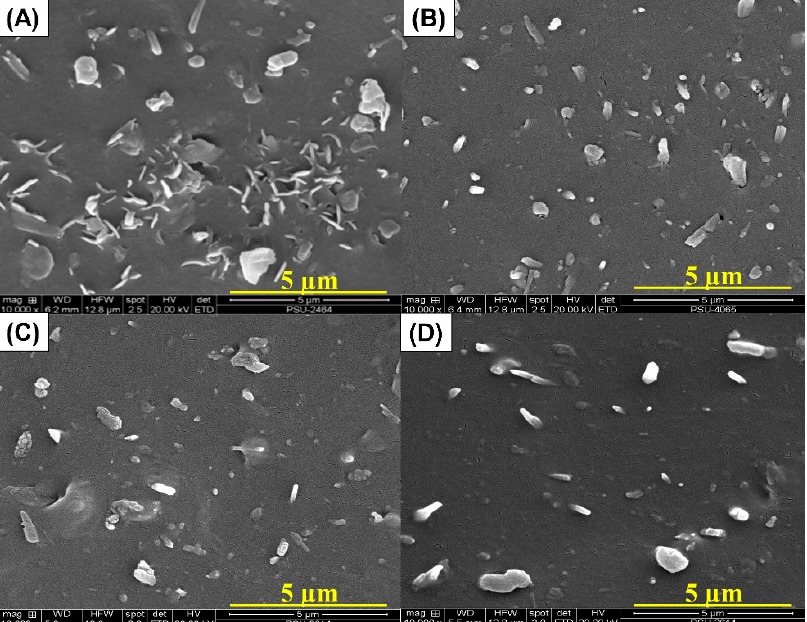
Figure 13. SEM images of the tensile fracture surfaces of NR/HNT composites in the presence of MNR/HNT as dual compatibilizers: reference ( A ), MPS 0 phr ( B ), MPS 0.5 phr ( C ), and MPS 1.5 phr ( D ), all at 10,000× magnification.